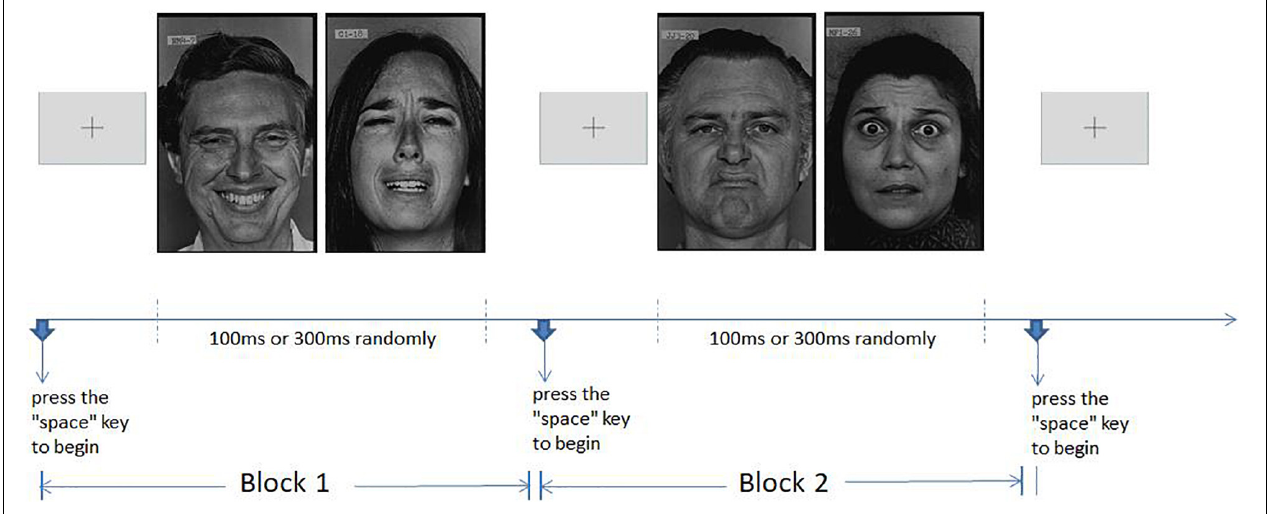
FIGURE 1 | Graph of experiment stimulation